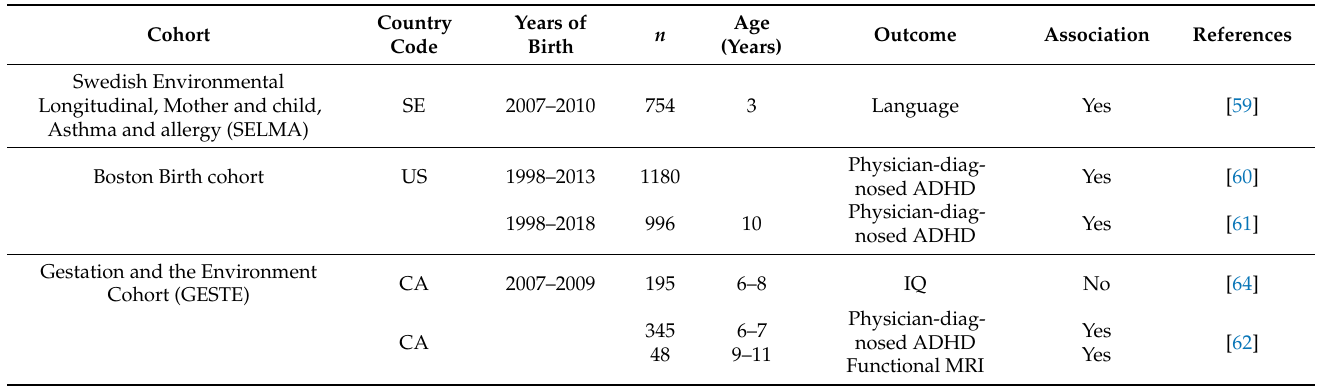
Table 2. Paracetamol intake measured by perinatal